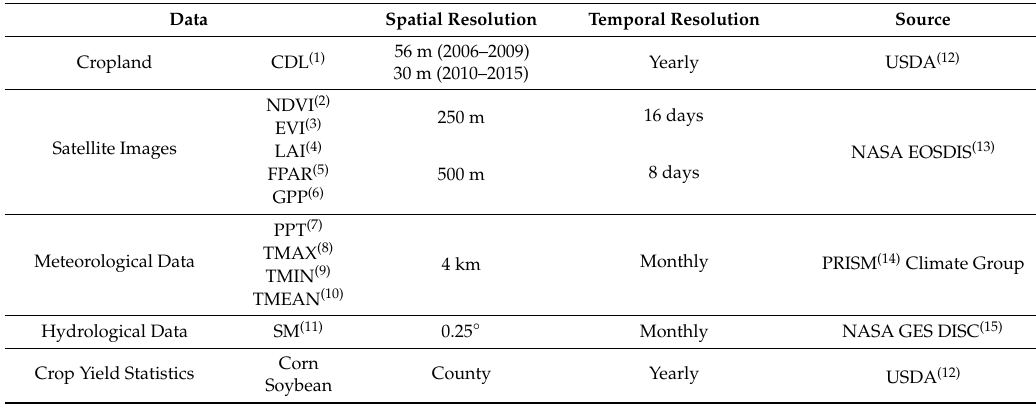
Table 1. Summary of the dataset used in this